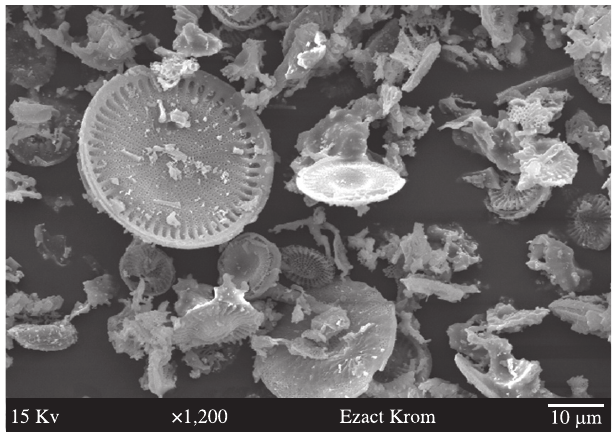
Figure 4. Typical scanning electron photomicrograph of Ezact Krom inorganic fraction. Particles can also be seen with circular holes and smaller particles with irregular shapes, probably from grinding of the circular particles.